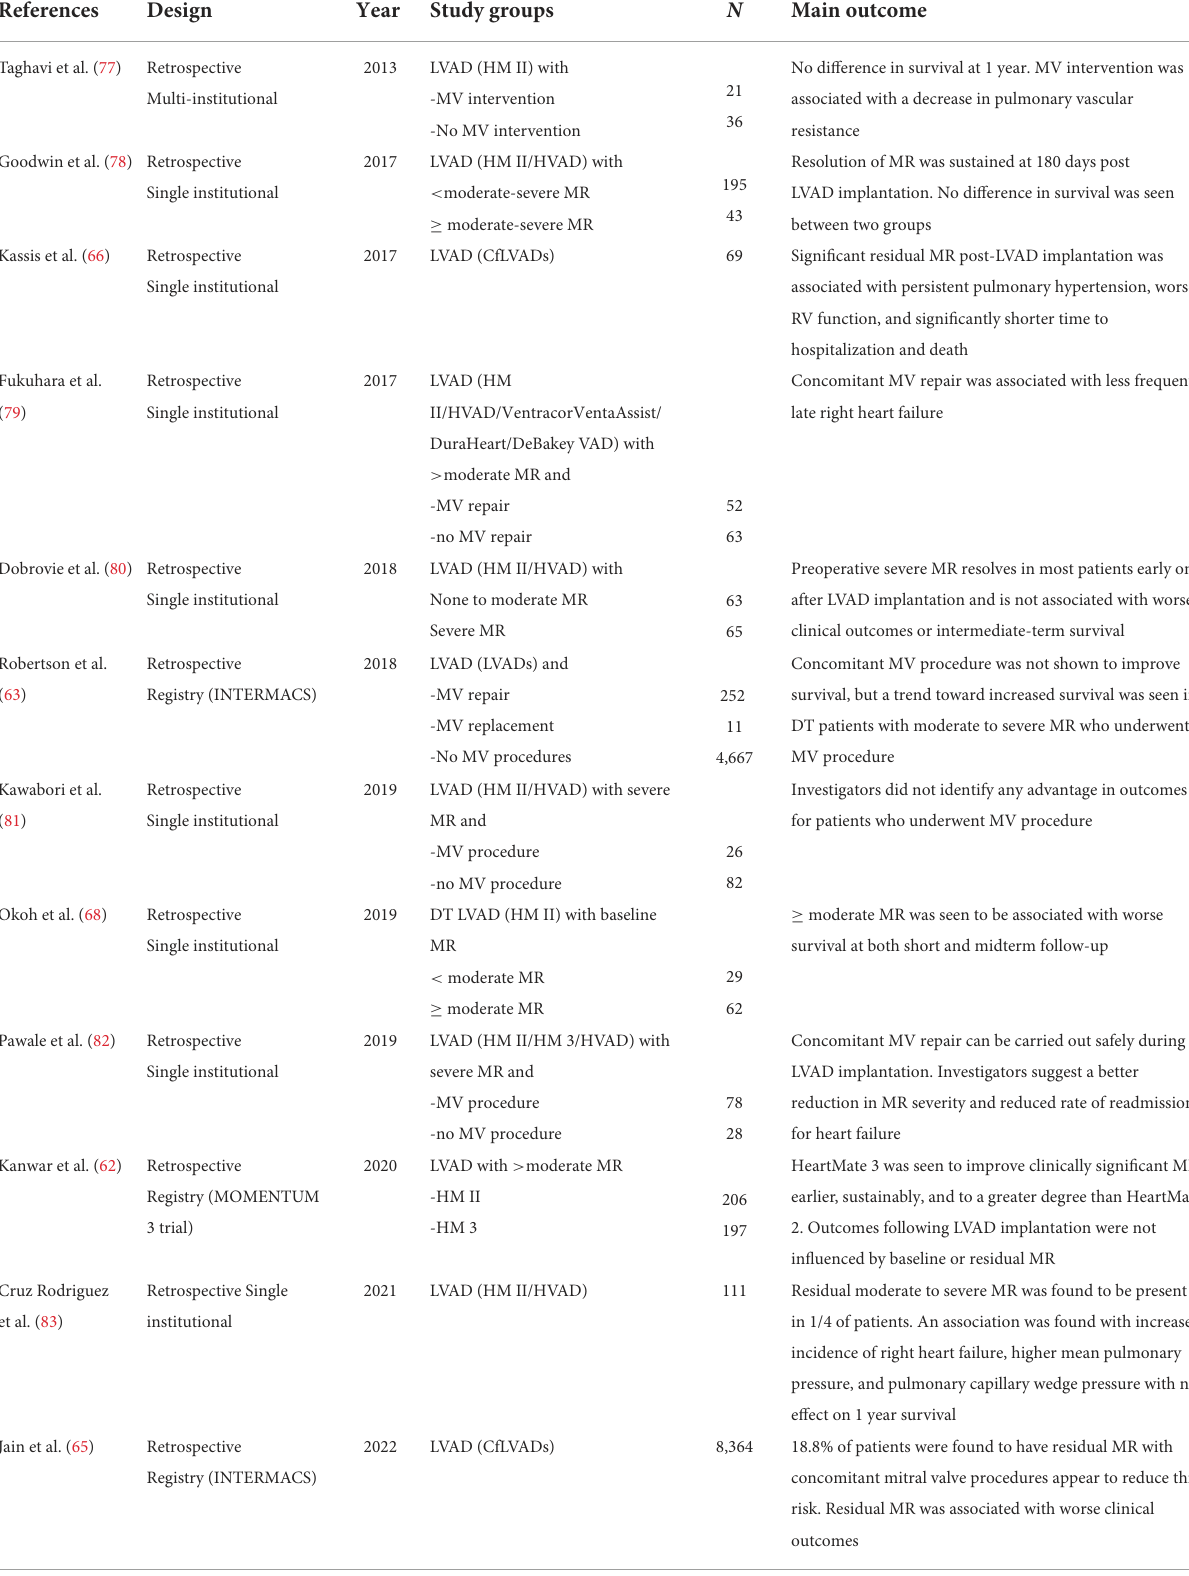
TABLE 2 Key studies in chronological order of publication reporting on the interaction of MR and LVAD